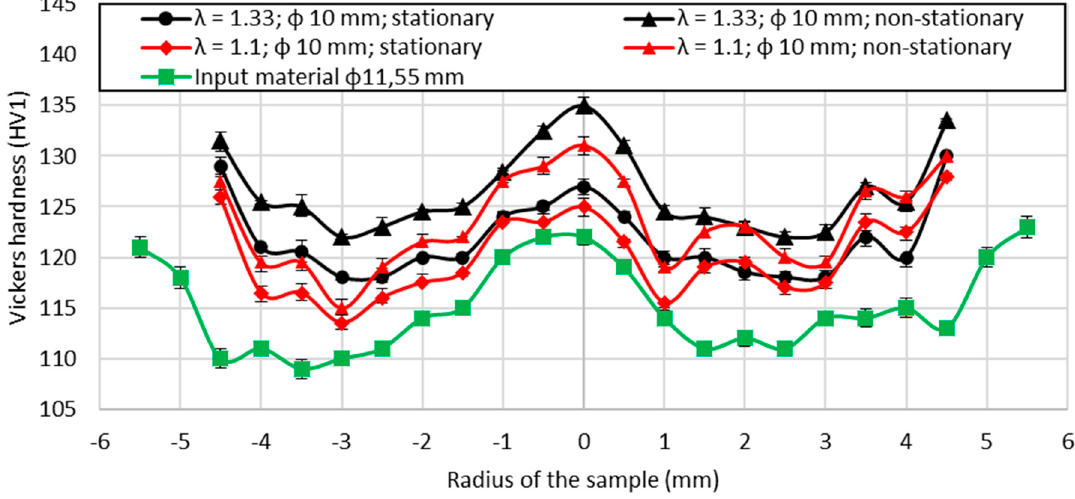
Figure 12. Vickers hardness measured at the axis of the cross-section (average values).